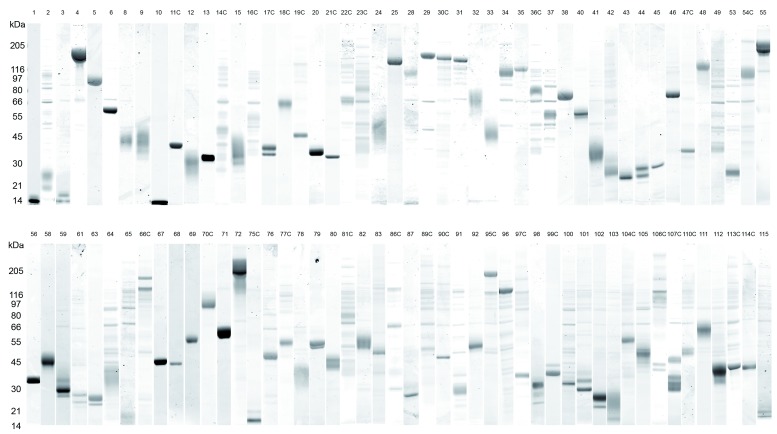
The 96 recombinant cell-surface or secreted
Schistosoma mansoni antigens produced in mammalian HEK-293E cells.Proteins were purified by Ni
2+-affinity purification using their carboxy-terminal 6-His tag and a small aliquot (2 µg) resolved by SDS-PAGE. Numbering of the proteins corresponds to Table 1. The suffix C indicates antigens that were produced with an additional rat Cd4d3+4 tag at their C-terminal end. Proteins were typically heterogeneous in mass, reflecting the presence of different glycoforms in the preparation. In the case of low-expressing proteins, contaminants originating from the cell culture supernatant occasionally co-purified alongside the protein of interest and appear as fainter background bands on the gels. Molecular masses (kDa) are indicated on the left-hand side of each composite picture. Adjustments to brightness and contrast for individual proteins were performed using the Adobe Photoshop CS5 software to improve clarity.